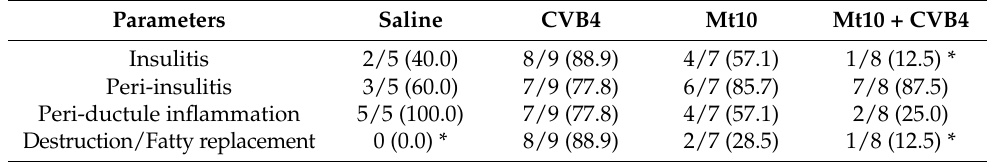
Table 1. Histological evaluation of pancreata in saline, CVB4, Mt10-infected, and Mt10-infected/ challenged